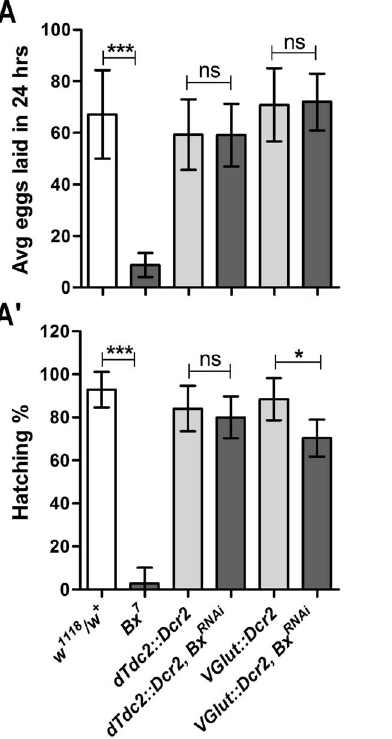
Figure 5. Knock down of Bx in the glutamatergic neurons but not in the octopaminergic neurons partially reduces female fertility. Knock down of Bx was performed in the octopaminergic neurons ( dTdc2 -Gal4) and glutamatergic neurons ( VGlut -Gal4) separate- ly and assessed for their fecundity (A) and fertility (A’). Knock down of Bx in octopaminergic neurons did not affect the female fecundity or fertility (A, A’) (no of eggs tested , 500 in control and test). Knock down of Bx in the glutamatergic neurons did not affect the female fecundity (A) but partially reduced fertility (A’) (unpaired t-test,*, p=0.0135, ***, p , 0.0001) (no of eggs tested , 800 in control and test).